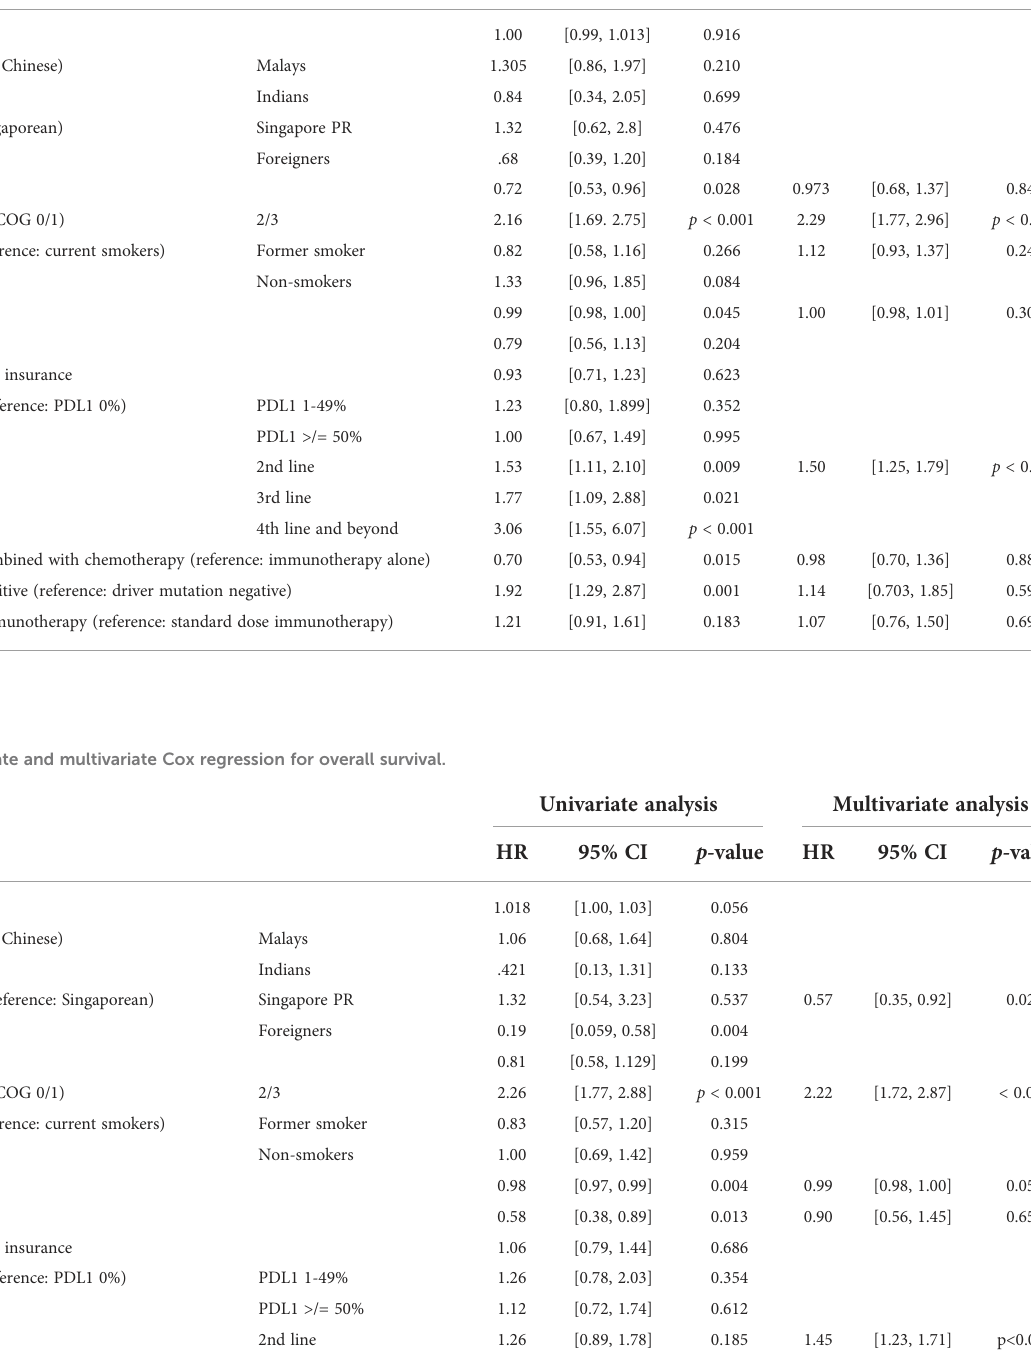
Univariate analysis